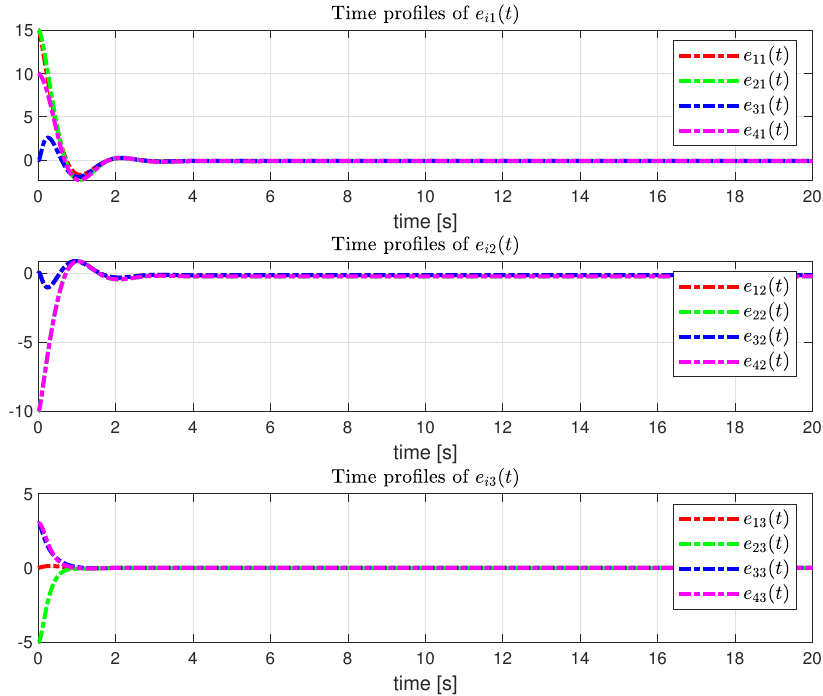
Figure 9. Performance of the control method in [29] under communication network ¯